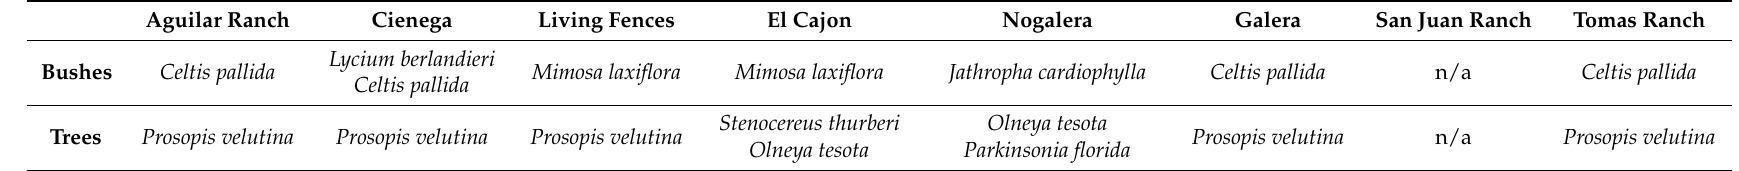
Table 7. Dominant bush and tree species by number of individuals in Desert Scrub stands for each